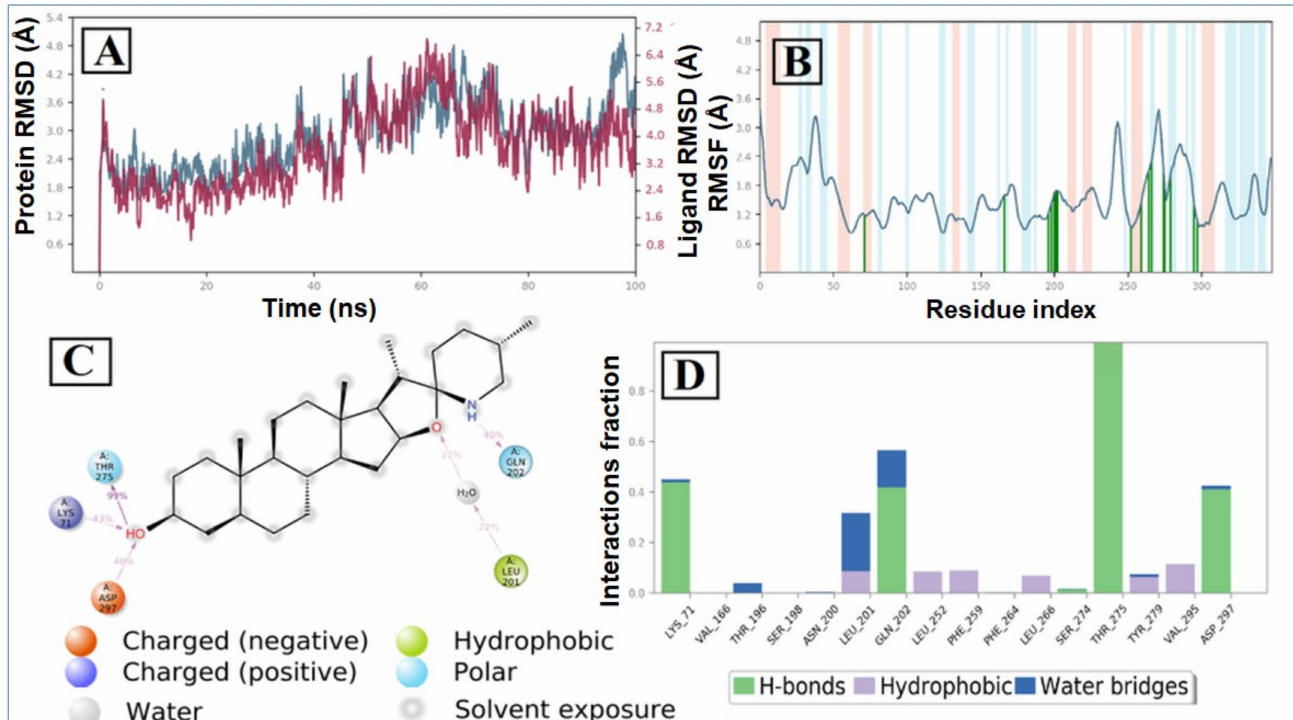
Figure 7. MD simulation analysis of tomatidine—SARS CoV-2 NSP15 complex: ( A ) RMSD (protein RMSD is shown in grey while RMSD of tomatidine are shown in red), ( B ) protein RMSF, ( C ) 2D interaction diagram and ( D ) protein–ligand contact analysis of MD